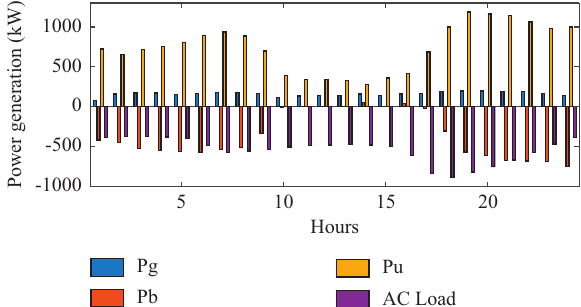
Figure 6: Day-ahead scheduling in the AC